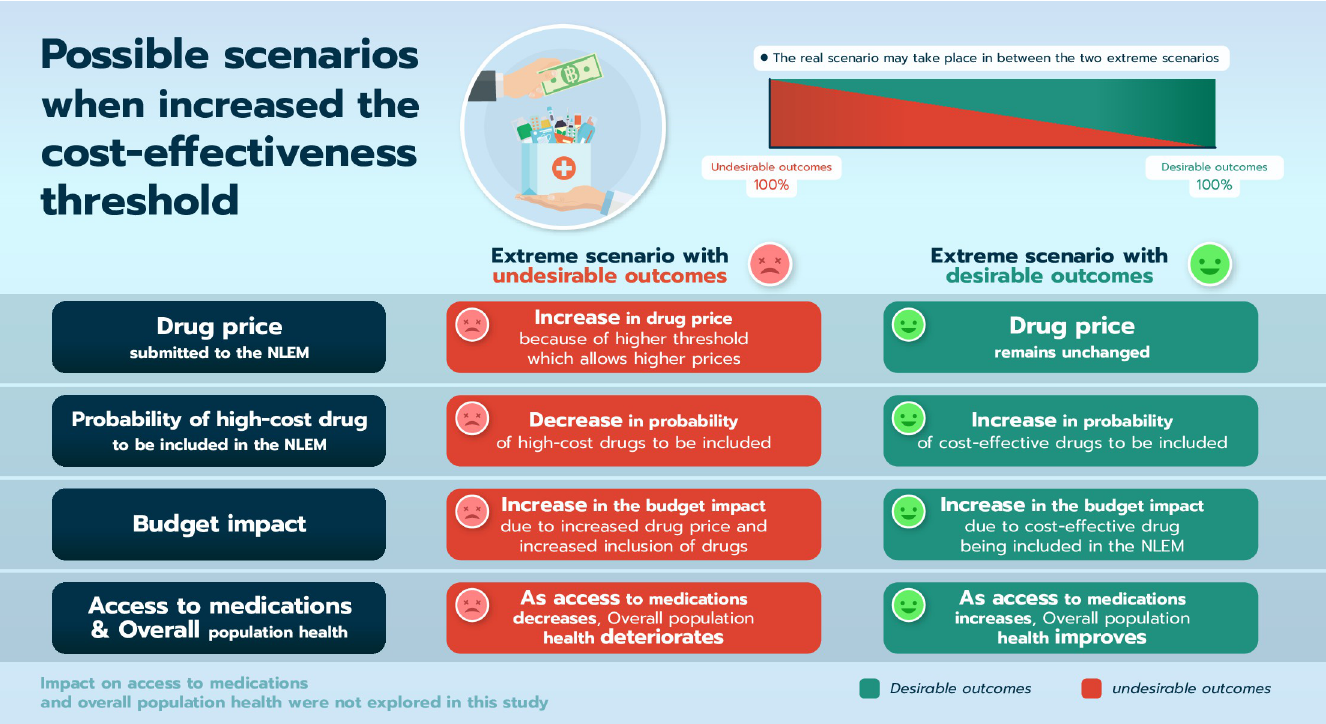
Fig 1. Framework of possible scenarios when a cost-effectiveness threshold